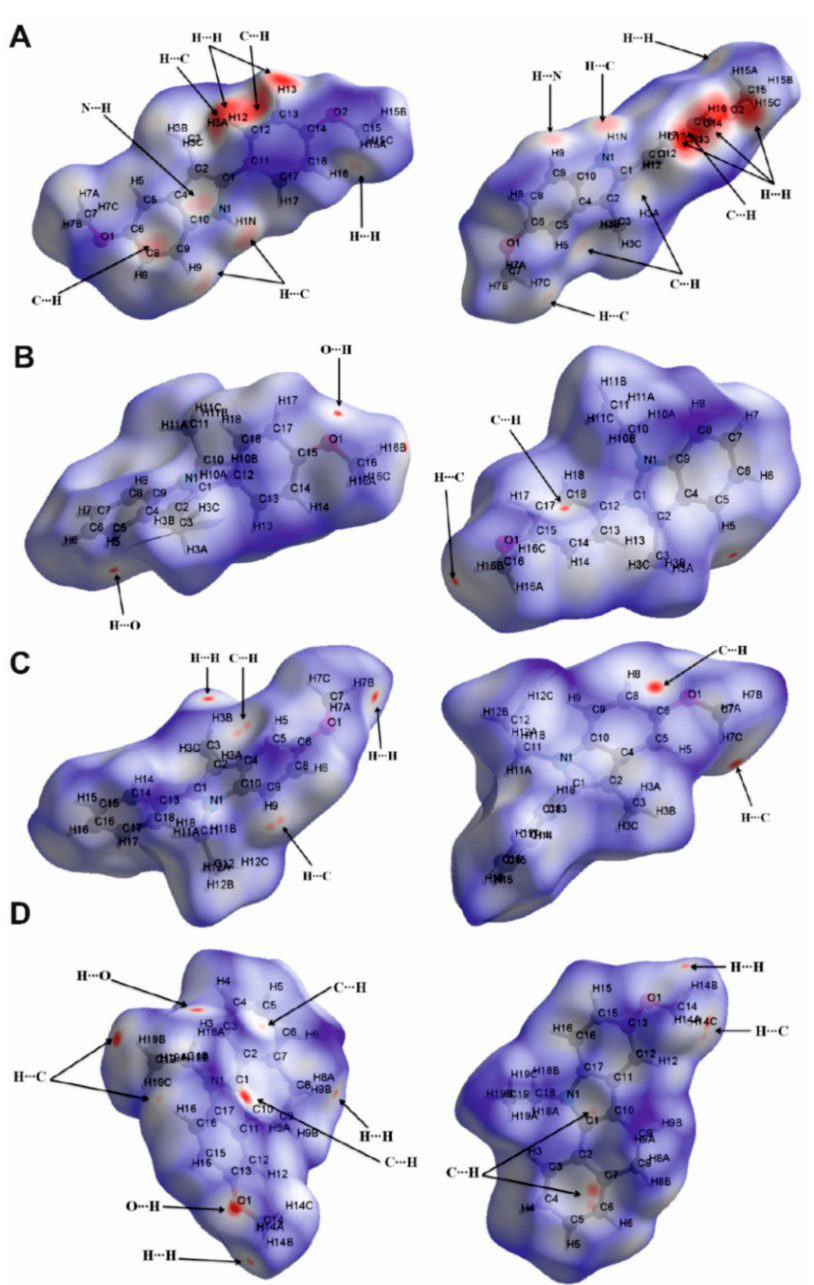
Figure 7. Two views of Hirshfeld surfaces mapped over d norm for compounds 1 ( A ), 2 ( B ), 3 ( C ) and 4 ( D